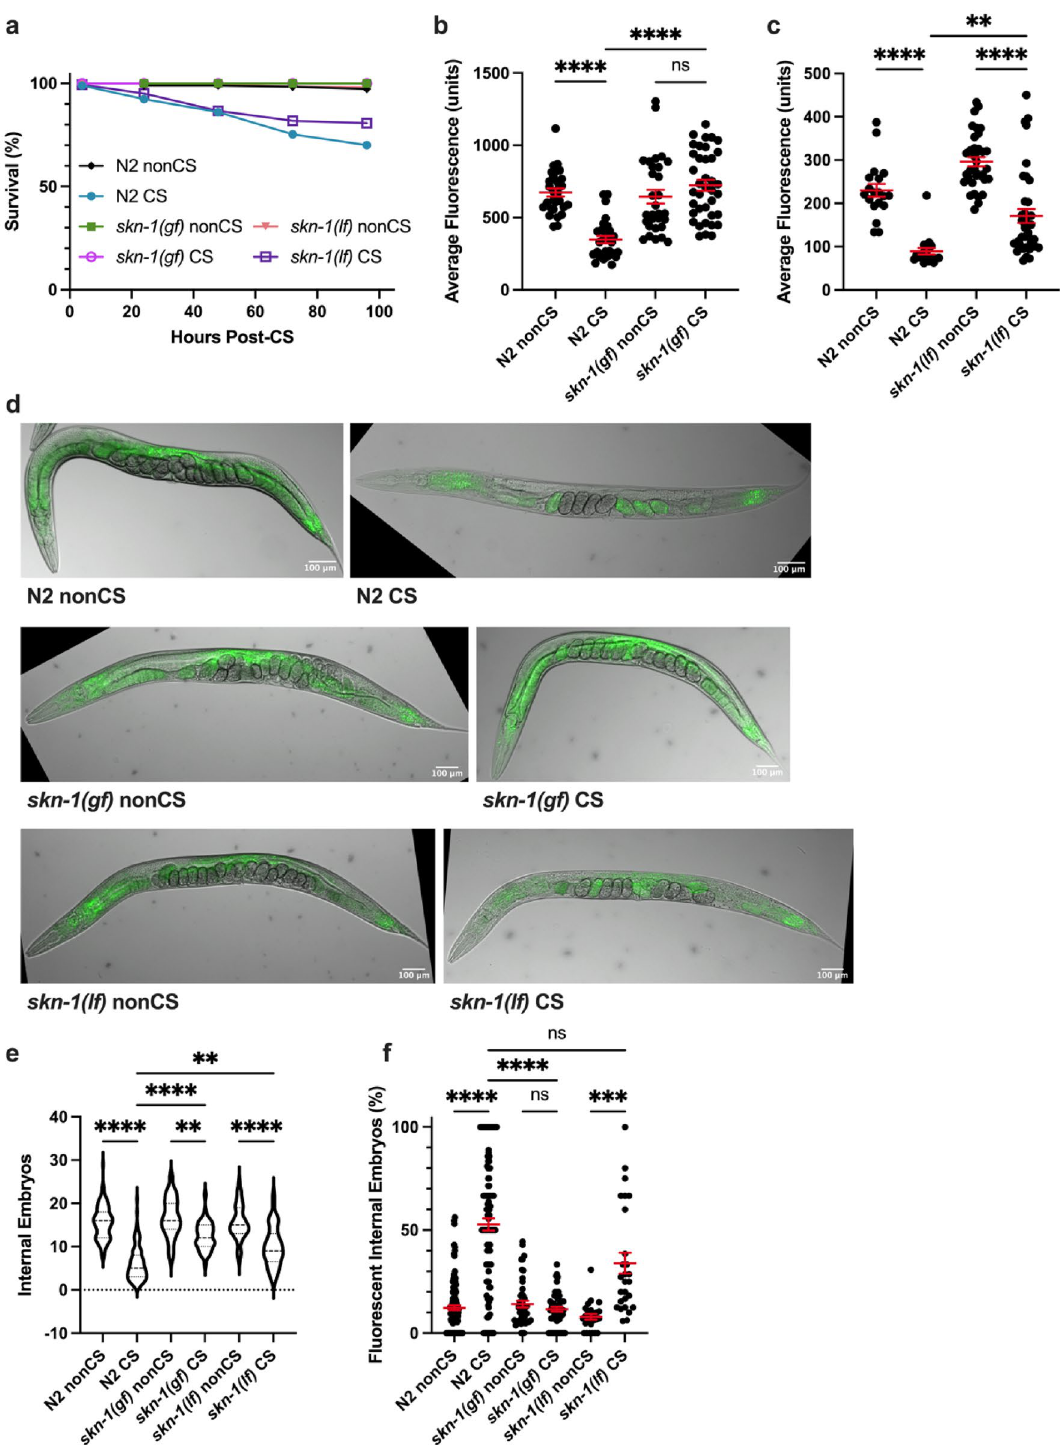
Figure 4. Activated SKN-1 prevents lipid relocalization following cold shock ( a ) skn-1(lax188) gain-of-function mutants and skn- 1(mg570) loss-of-function mutants were cold shocked and recovered while monitoring survival rates (n ≥ 120 worms per condition). ( b-c ) At 12 h post-CS or control nonCS, (b) skn-1(lax188) and (c) skn-1(mg570) were Nile Red lipid-stained and average fluorescence per worm quantified (N2 v. skn-1(lax188) - Kruskal–Wallis test: H = 47.46, P < 0.0001; Dunn’s Multiple Comparison test: **** P < 0.0001; N2 v. skn-1(mg570) - Kruskal–Wallis test: H = 64.55, P < 0.0001; Dunn’s Multiple Comparison test: ** P = 0.0064, **** P < 0.0001). ( d ) Relative to wild-type N2s, representative images of skn-1(lax188) mutants show maintenance of intestinal fluorescence contrary to skn-1(mg570) , which show lipid relocalization. ( e ) Number of embryos (Kruskal–Wallis test: H = 223.1, P < 0.0001; Dunn’s Multiple Comparison test: **P skn-1(gf) nonCS vs. CS = 0.0020, **P N2 CS vs. skn-1(lf) CS = 0.0014, **** P < 0.0001) and ( f ) percent of fluorescent internal embryos (Kruskal–Wallis test: H = 132.0, P < 0.0001; Dunn’s Multiple Comparison test: *** P = 0.0002, **** P < 0.0001) were quantified per worm from Nile Red images (n ≥ 26 worms per condition for b-e; error bars are mean ±